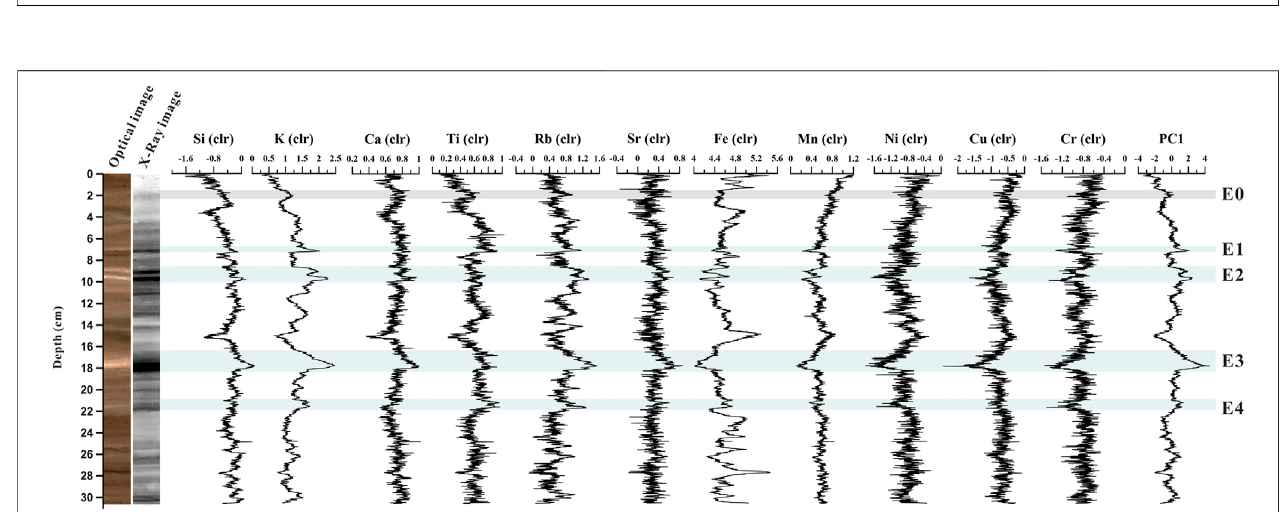
FIGURE 3 | Variations of element contents and PC1 values in the core MGC21A. E0- fl ood event; E1, E2, E3, and E4- earthquake events.